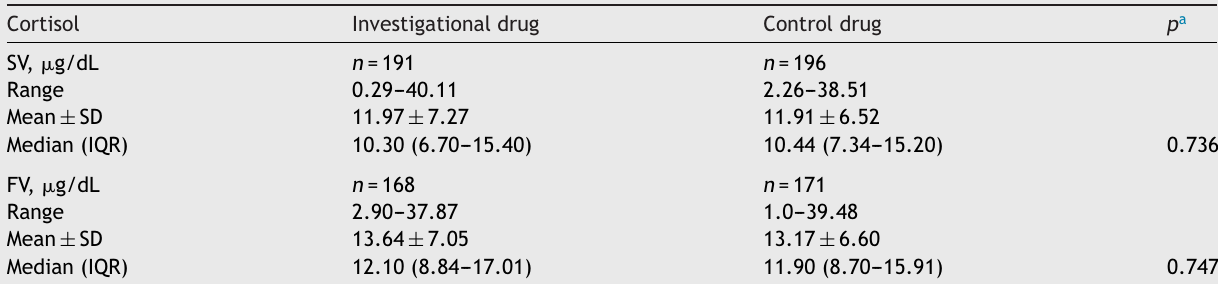
SD, standard deviation; IQR, interquartile range; SV, screening visit; FV, final visit. a Mann---Whitney